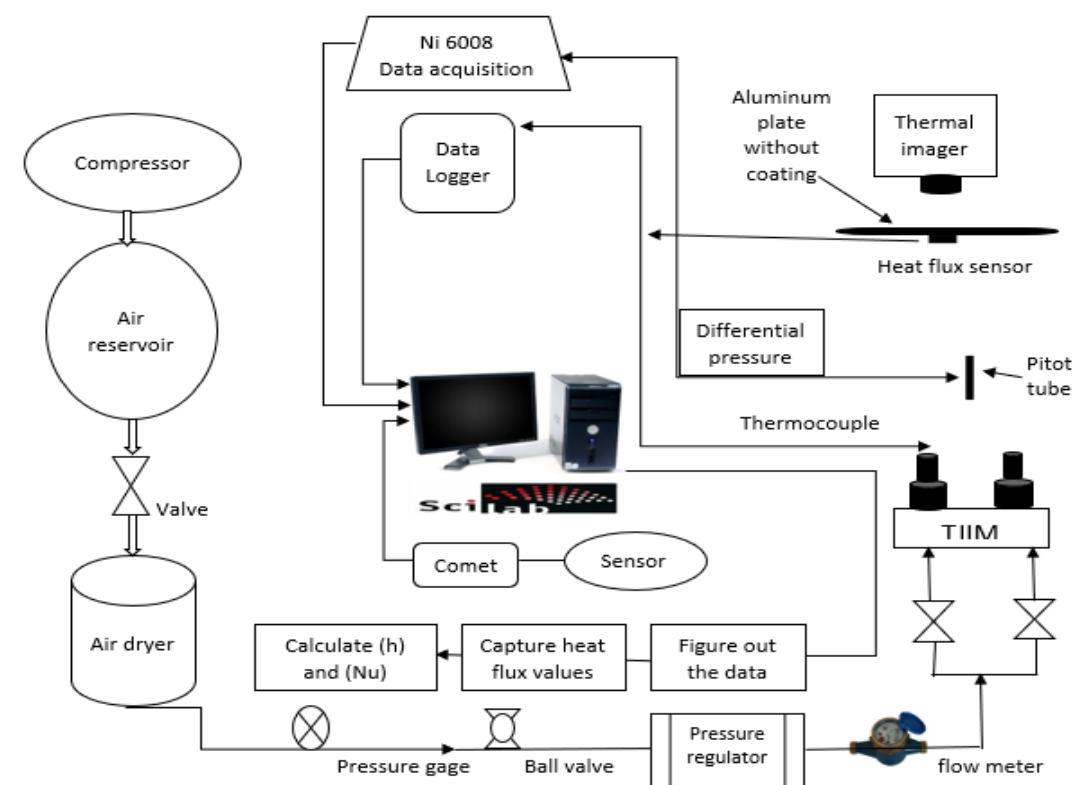
Figure 1. A schematic diagram of the heat transfer test and the thermal imaging setup.